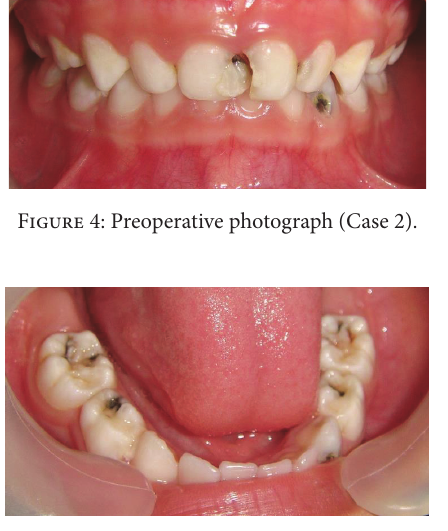
Figure 5: Preoperative photograph (Case 2 ).